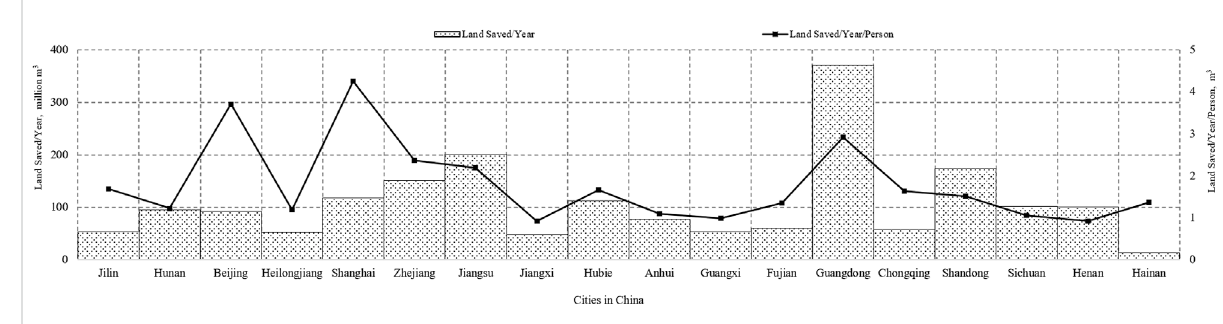
FIGURE 2 The total and per-capita land use saved per year through utilization of